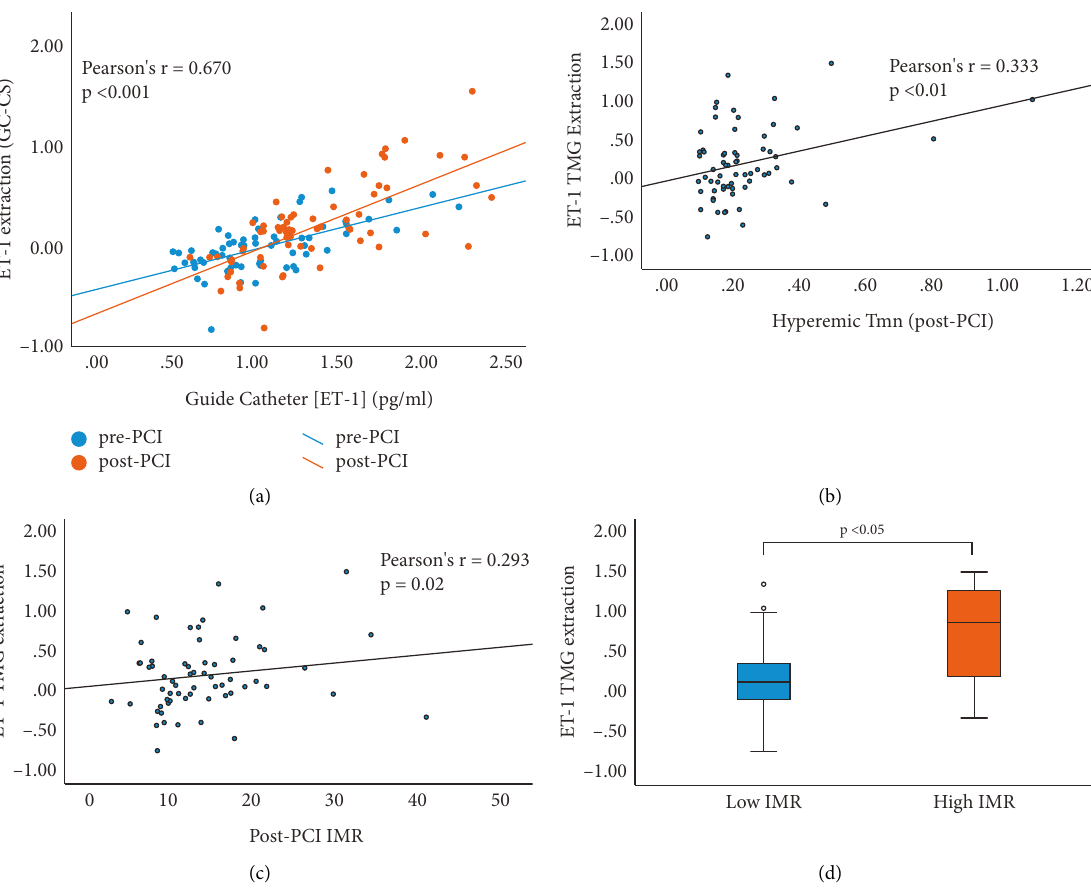
Figure 2: (a)ET-1extraction(Guidecatheter–coronarysinusET-1inpg/ml)isproportionaltoincreasedupstreamET-1intheguidecatheter stationed in the aortic root both pre-PCI and post-PCI. (b) ET-1 TMG extraction (refers to post-PCI guide catheter CS ET-1 corrected for baselineTMGbysubtractingpre-PCIguidecatheter-CSET-1)correlateswithdecreasedhyperemicflowandincreasedTmn.(c)Similarlywith IMRc measured post-PCI. (d) ET-1 TMG extraction is significantly higher in the subgroup of patients with post-PCI IMRc ≥